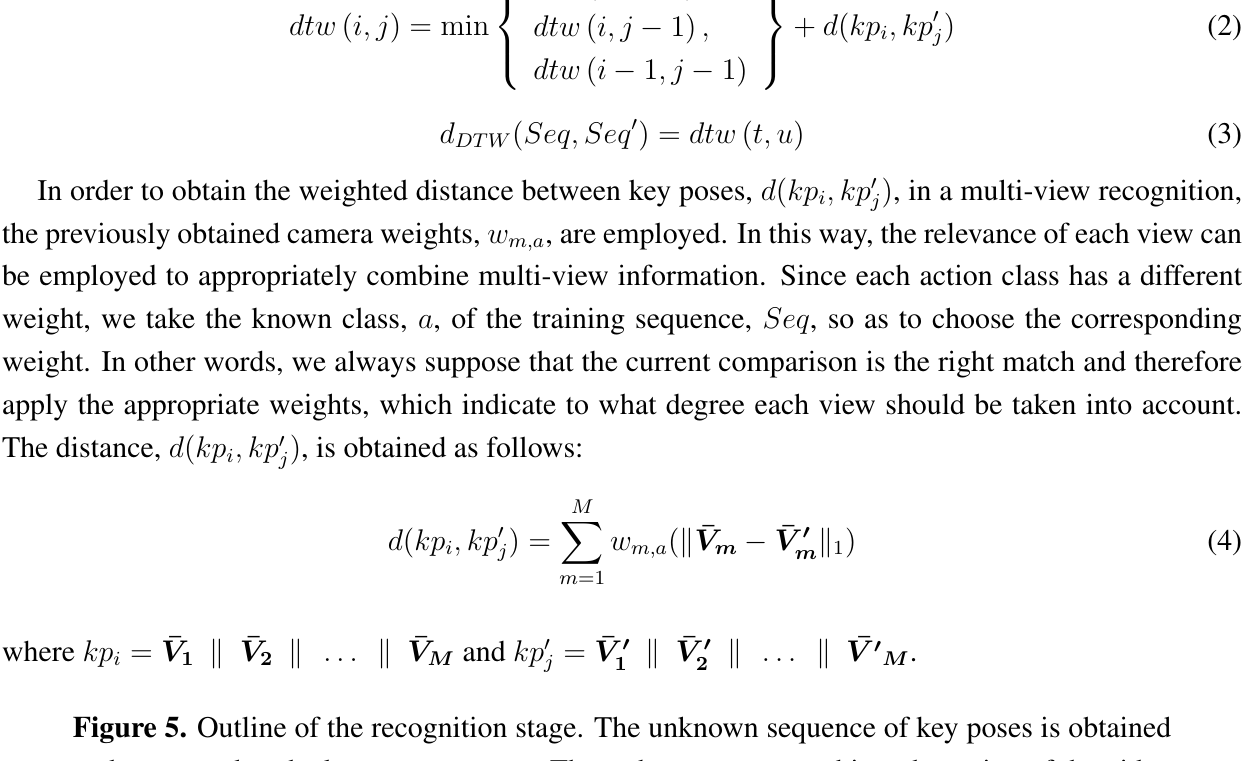
Figure 5. Outline of the recognition stage. The unknown sequence of key poses is obtained and compared to the known sequences. Through sequence matching, the action of the video sequence can be